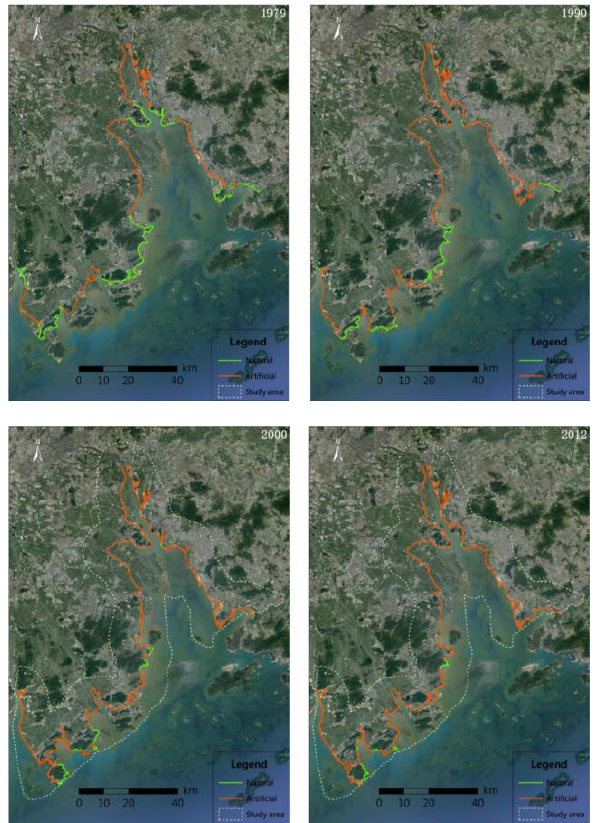
Figure 3. Change of coastline type in the PRD (1979~2012)